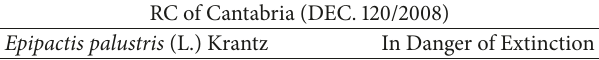
Table 10: Species included in the regional catalogue (RC) of Cantabria (DEC.